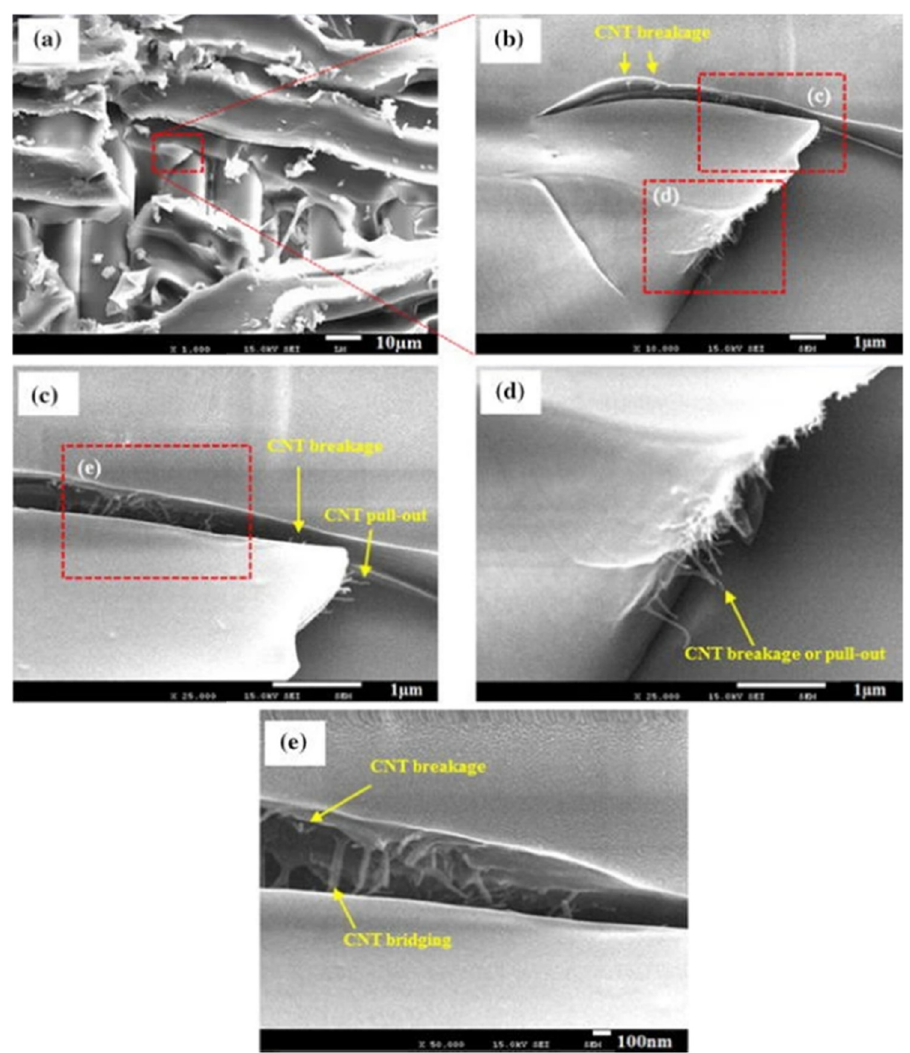
Figure 19: Microscope failure mechanisms of 0.75% MWCNT - modi fi ed GFRPs under 22 J impact, ( a ) glass fi ber bridging and debonding, ( b ) matrix cracks, and ( c ) – ( e ) CNT failure